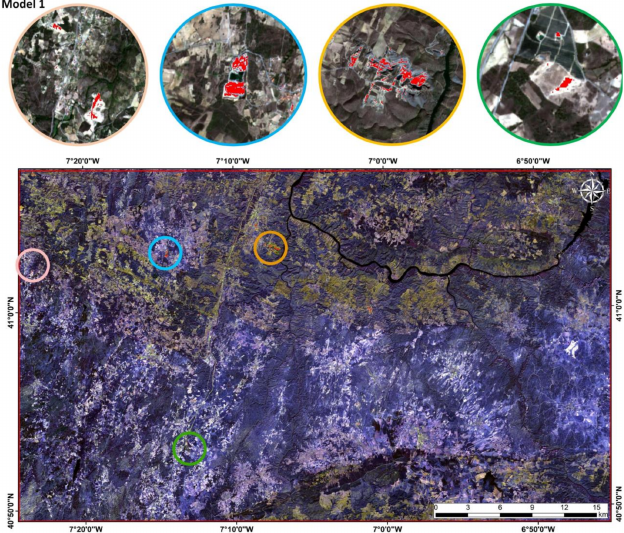
Figure 8. Example areas of possible false positives (misclassified pixels) from Remote Sensing Model 1: P ó voa de Penela, Touça (light brown), Touça (blue), Poio’s quarry (orange), and Marialva